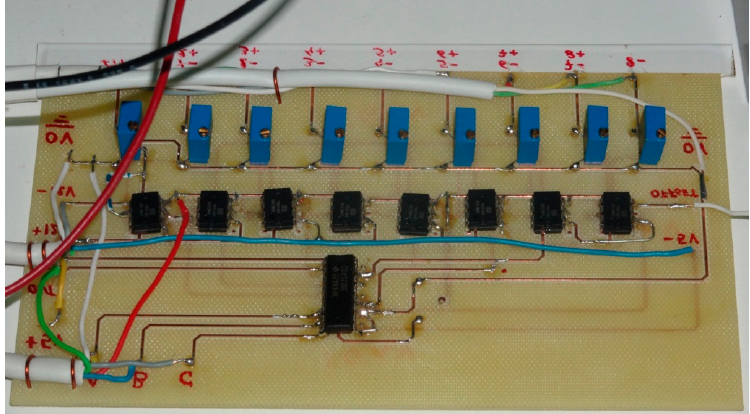
Figure 10. Assembled AMB under laboratory tests.